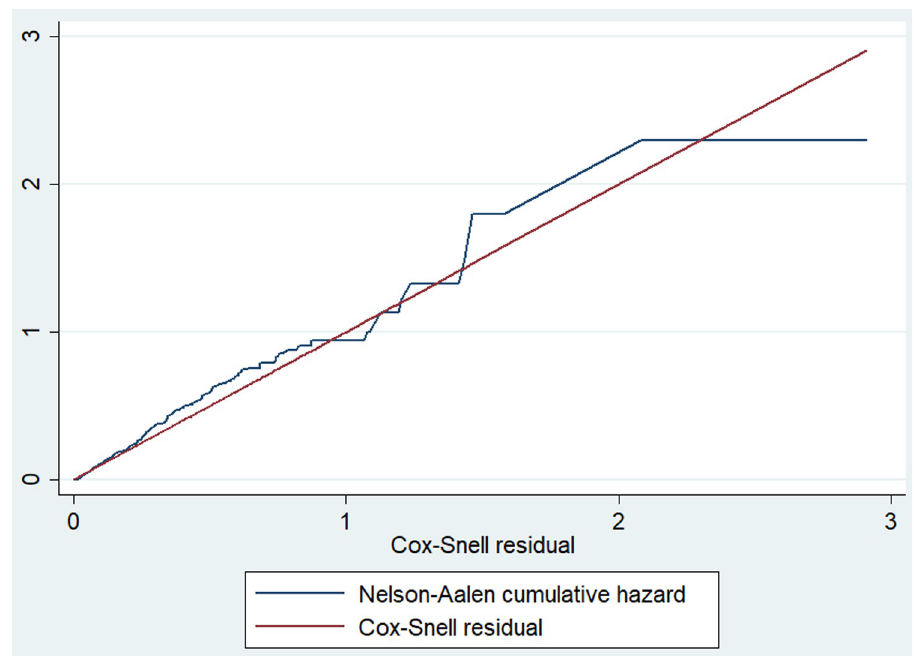
Fig 3. Cox-Snell residuals plot for fitting Cox-model for both individual and community-level predictors of under-five mortality in rural Ethiopia.